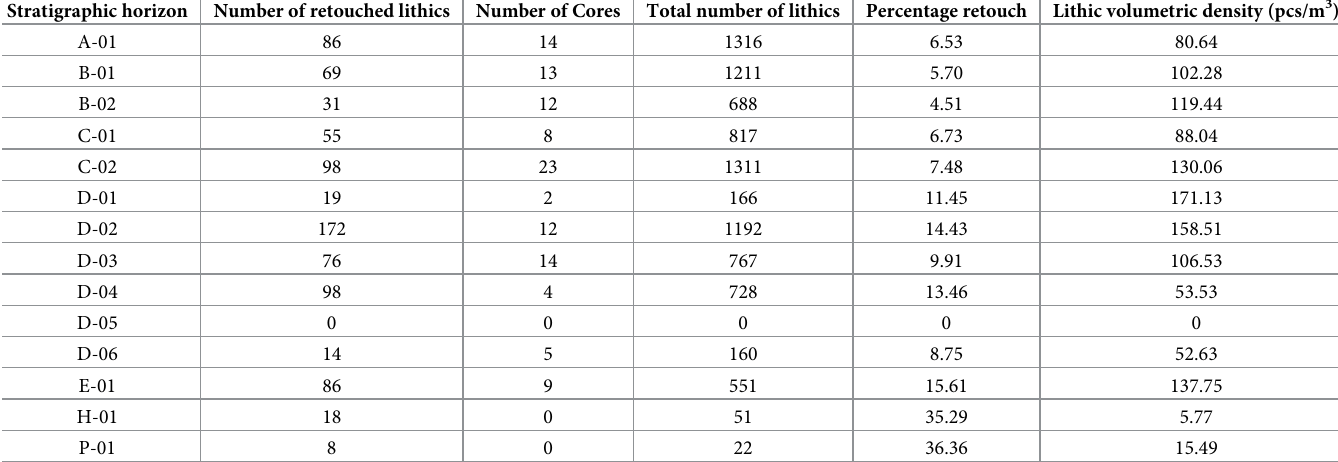
Table 1. Lithic counts for each of the levels identified in the West Trench (Fig 5). Level N-01 is the natural ‘virgin soil’ devoid of traces of human activity and is thus excluded. Stratigraphic